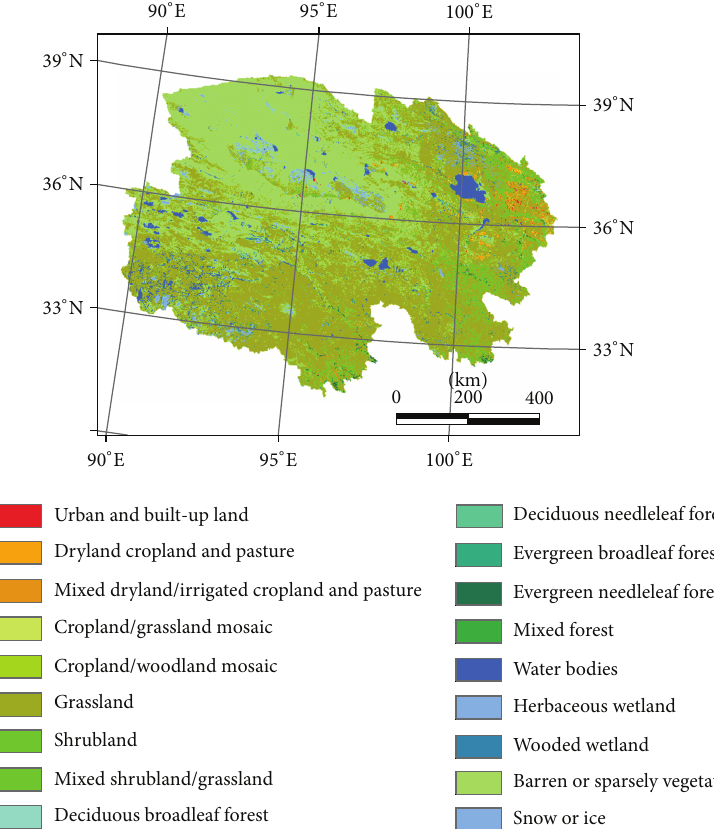
Figure 1: Location and land uses/cover in Qinghai Province of China in